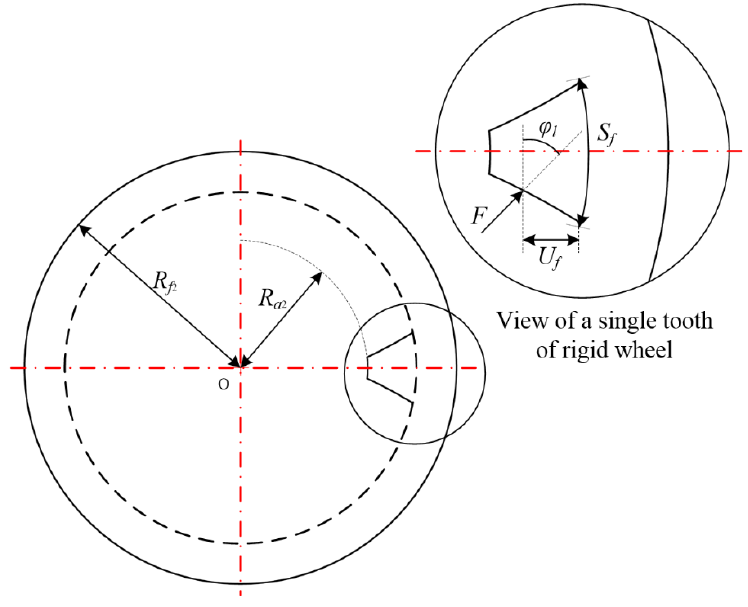
Figure 11. Geometrical parameters of k f 2 . Table 1. Values of the coefficients of Equation (43).